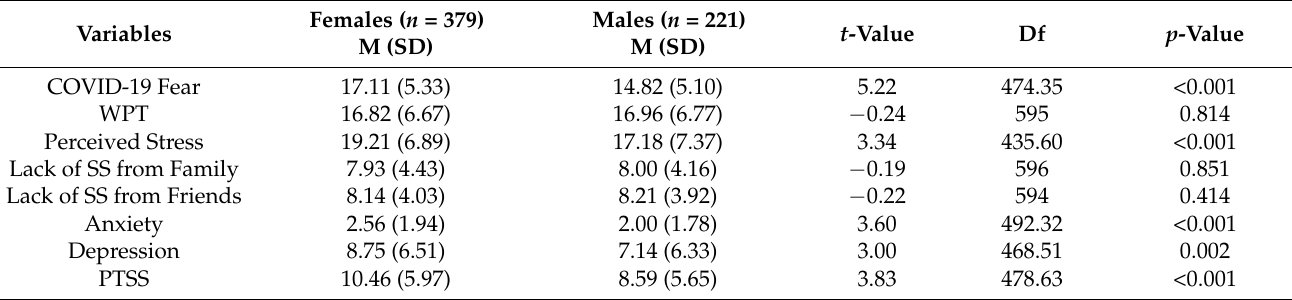
Table 3. Differences among variables of interest by gender identity ( n =